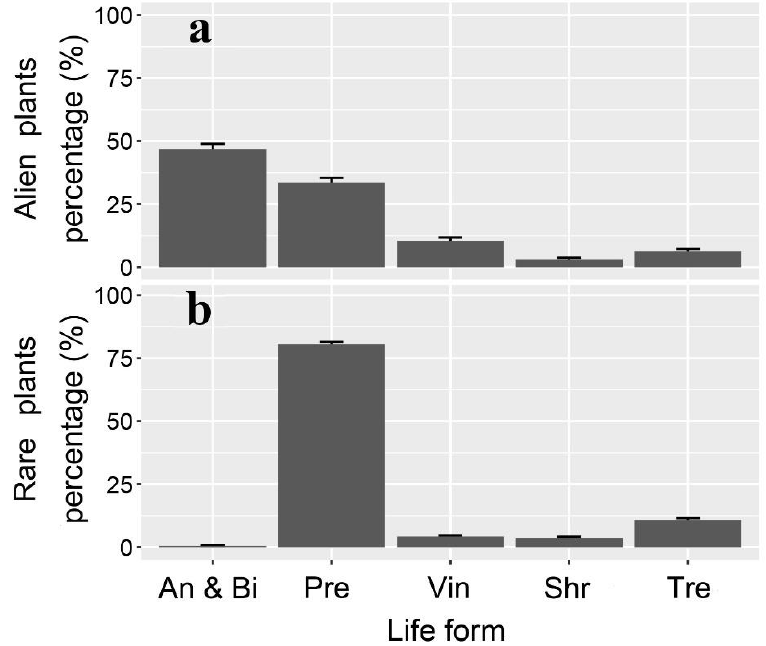
Figure 3. Percentage of life forms of alien ( a ) and rare plants ( b ). An and Bi, annual and biennial herb; Per, perennial herb; Vin, vines; Shr, shrubs; Tre, trees. Error bars represent standard error .